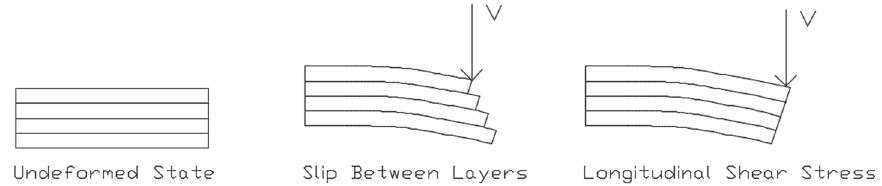
Figure 1. Longitudinal shear stress in a beam.